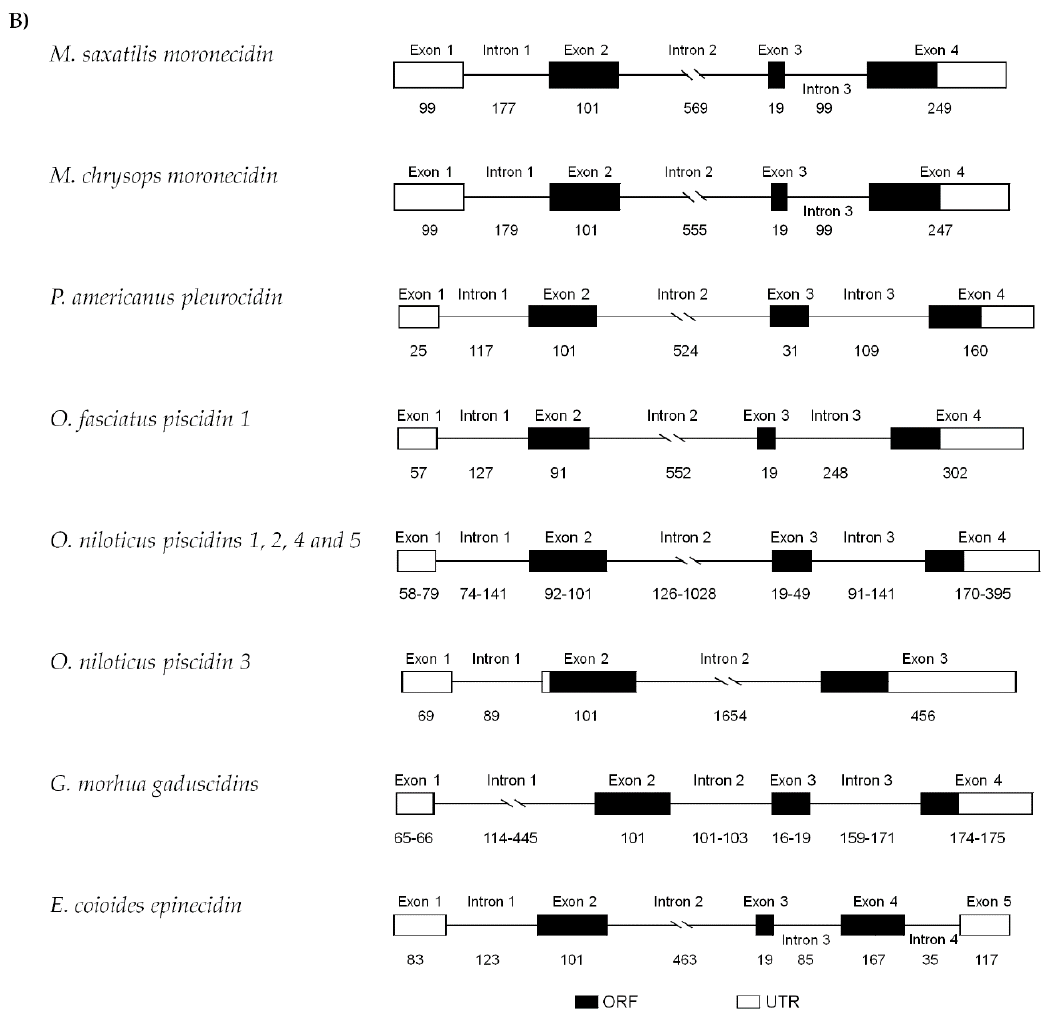
Figure 3. Genomic organization of sea bass piscidin genes. ( A ) Exon / intron diagram of sea bass piscidin genes and their position in the two different contigs of whole genome shotgun sequences. ( B ) Comparative view with other fish species. Exons are shown as boxes and introns as solid lines, with sizes in base pairs indicated below. Regions with unknown sizes are shown as dashed lines.